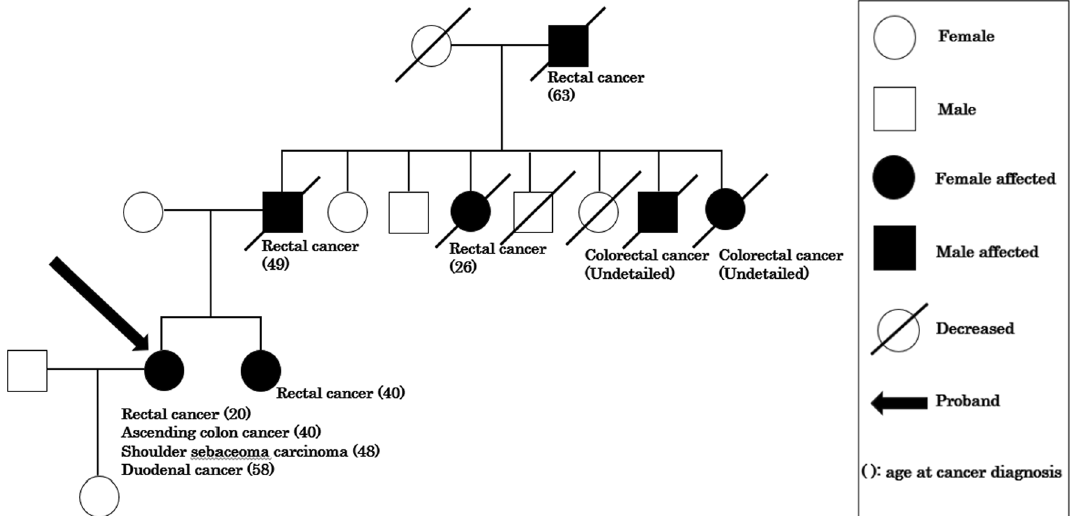
Fig. 3 The pedigree chart of the